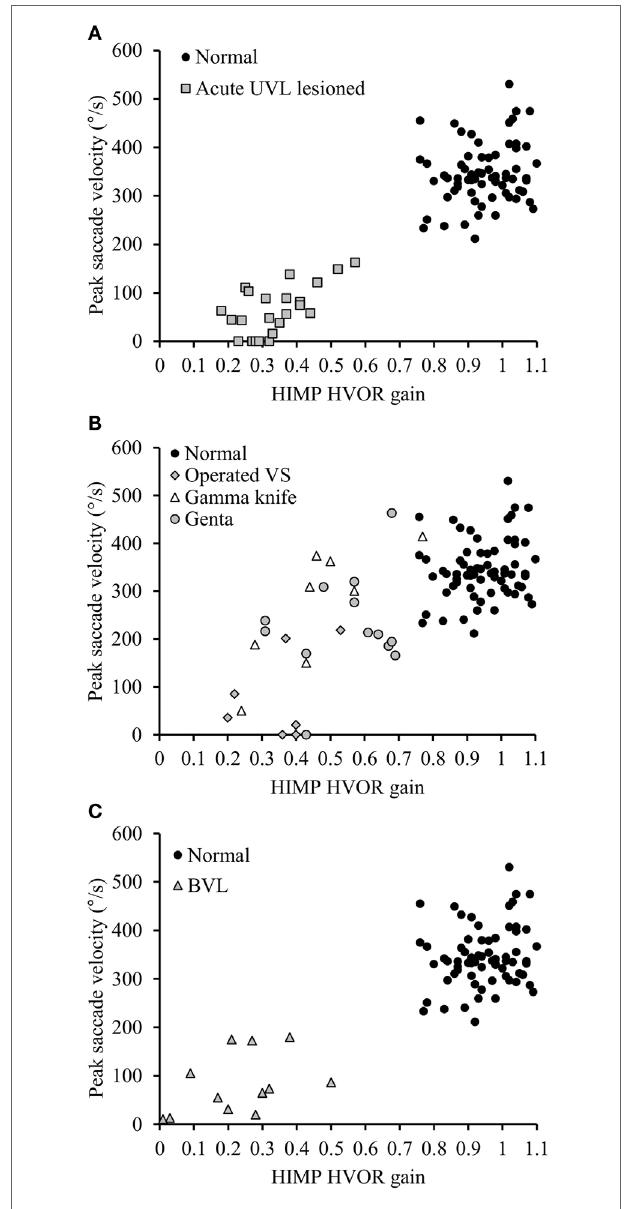
FigUre 4 | Peak saccade velocity in function hiMP hVOr gain in normal subjects and in patients suffering from different vestibular pathologies and tested at different stages following the lesion . (a) Peak saccade velocity in UVL patients operated for vestibular schwannoma tested at acute stage and normal subjects. Notice that when HIMP gain is low, the peak saccade velocity in acute UVL patients (gray squares) was significantly lower than the ones in normal subjects (black circles). (B) Patients suffering from different vestibular pathologies and areflexic to the caloric test were tested with SHIMPs at chronic stage. Again that the SHIMPs peak saccade velocity vary in function of the HIMP HVOR gain. Gray diamonds: patients with vestibular schwannoma operated after 6 weeks; empty triangle: patients with vestibular schwannoma treated by gamma knife; gray circles: patients suffering from Meniere’s disease and treated by intratympanic gentamycin injection. (c) Peak saccade velocity in BVL Patients and normal subjects. Notice that when HIMP gain is low, the peak saccade velocity in BVL patients (gray triangles) was significantly lower than the ones in normal subjects (black circles).